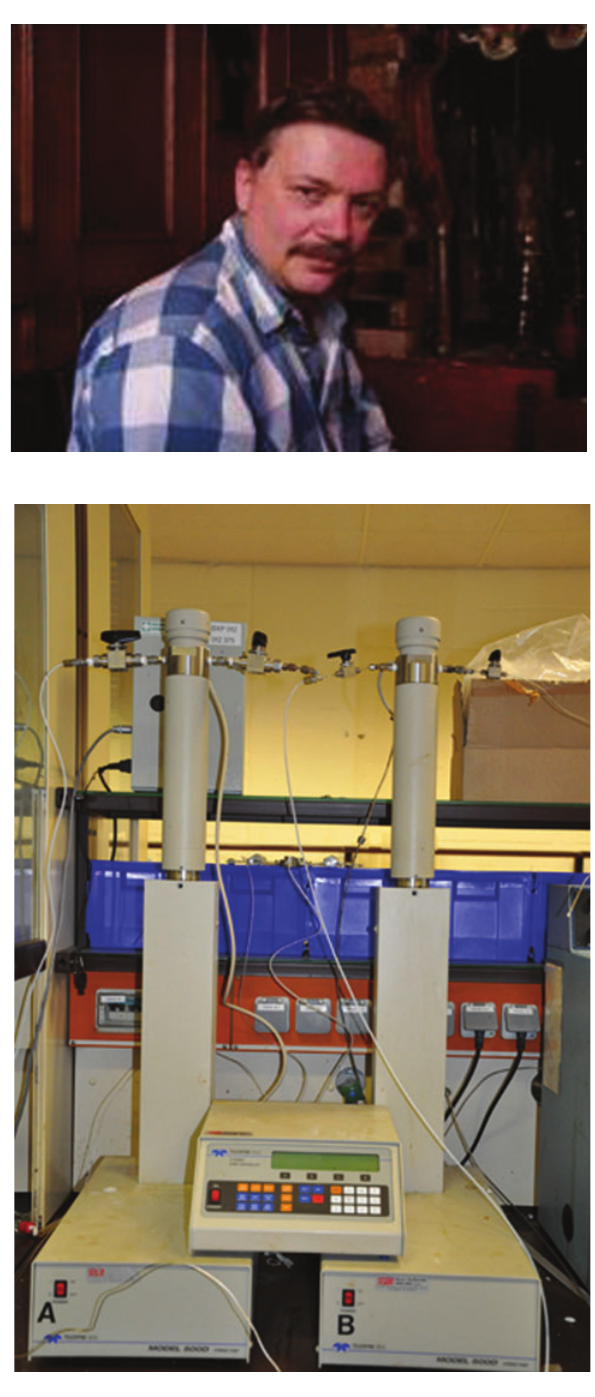
Figure 1 High pressure Isco syringe pumps from